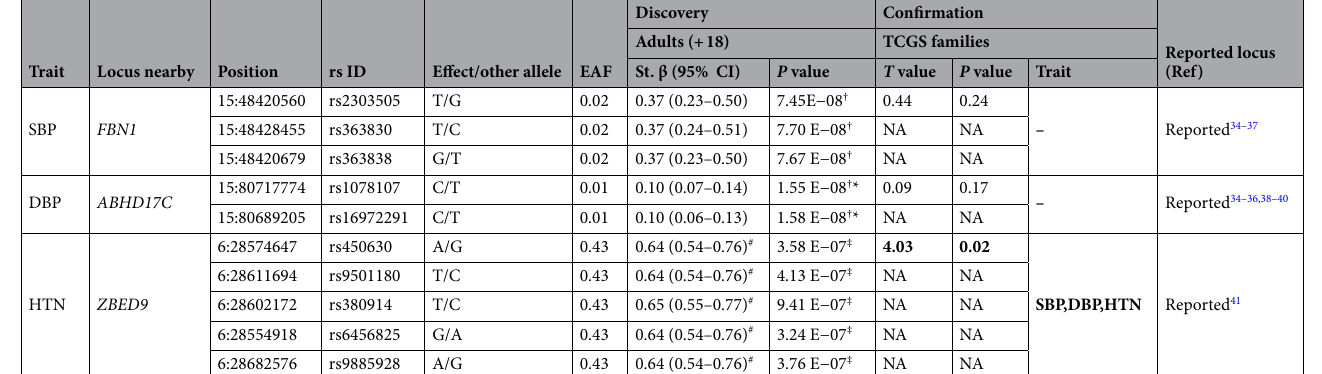
Table 2. GWA findings on BP traits in discovery and confirmation studies. EAF effect allele frequency in TCGS, St. β standardized effect estimate, CI confidence interval. NA not applicable due to removing variant in LD pruning process (r 2 > 0.2 ). † Reach the genome-wide borderline P value threshold after adjustment for WC. *Reach genome-wide threshold after adjustment for age and sex. ‡ Reach the genome-wide borderline P value threshold after adjustment for BMI/WC. # Odds